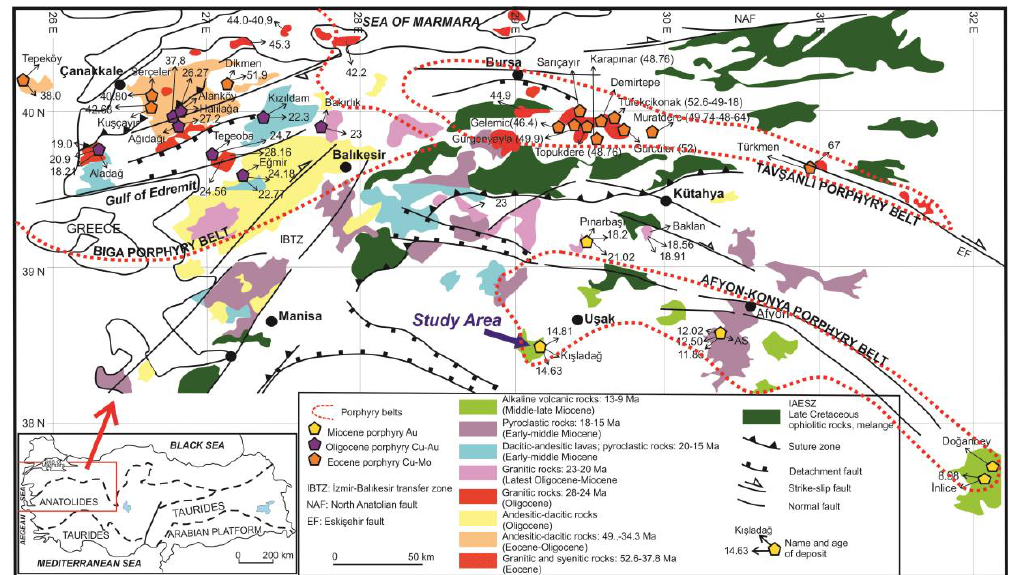
Figure 1. Simplified regional geological map of western Anatolia (location shown in the inset) showing Eocene to Miocene magmatic rocks and porphyry ore deposit belts (simplified from